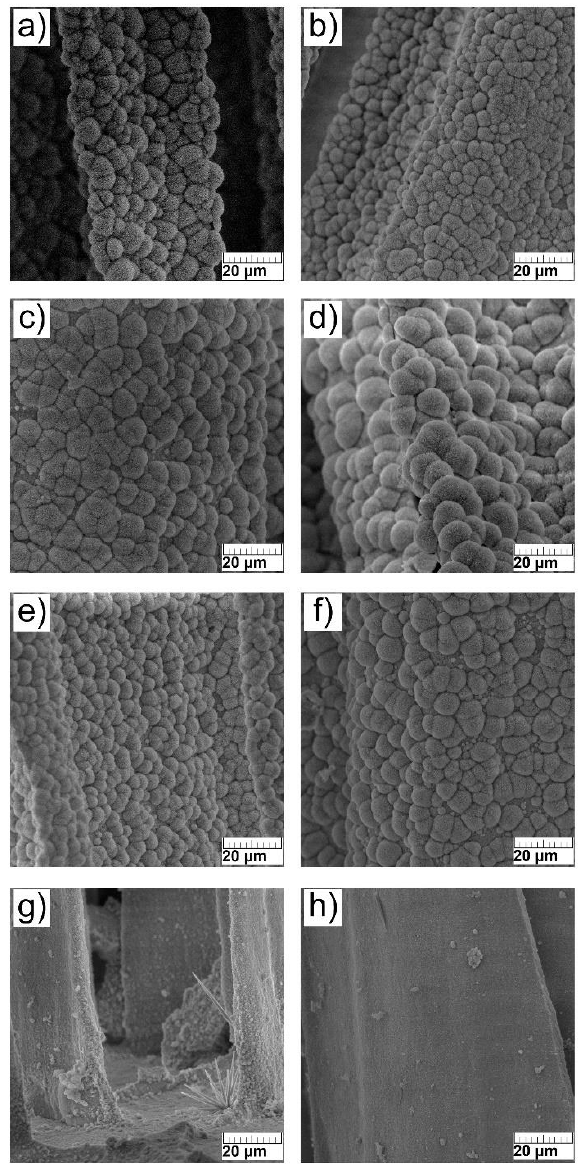
Figure 3. SEM micrographs of the surface of scaffolds: ( a ) 1-Sr-CaP, ( b ) 2.5-Sr-CaP, ( c ) 5-Sr-CaP, ( d ) 10-Sr-CaP, ( e ) 1-Mg-1-Sr-CaP, ( f ) 1-Mg-5-Sr-CaP, ( g ) 5-Mg-1-Sr-CaP, ( h ) 5-Mg-5-Sr-CaP. (scale bar: 20 µm).